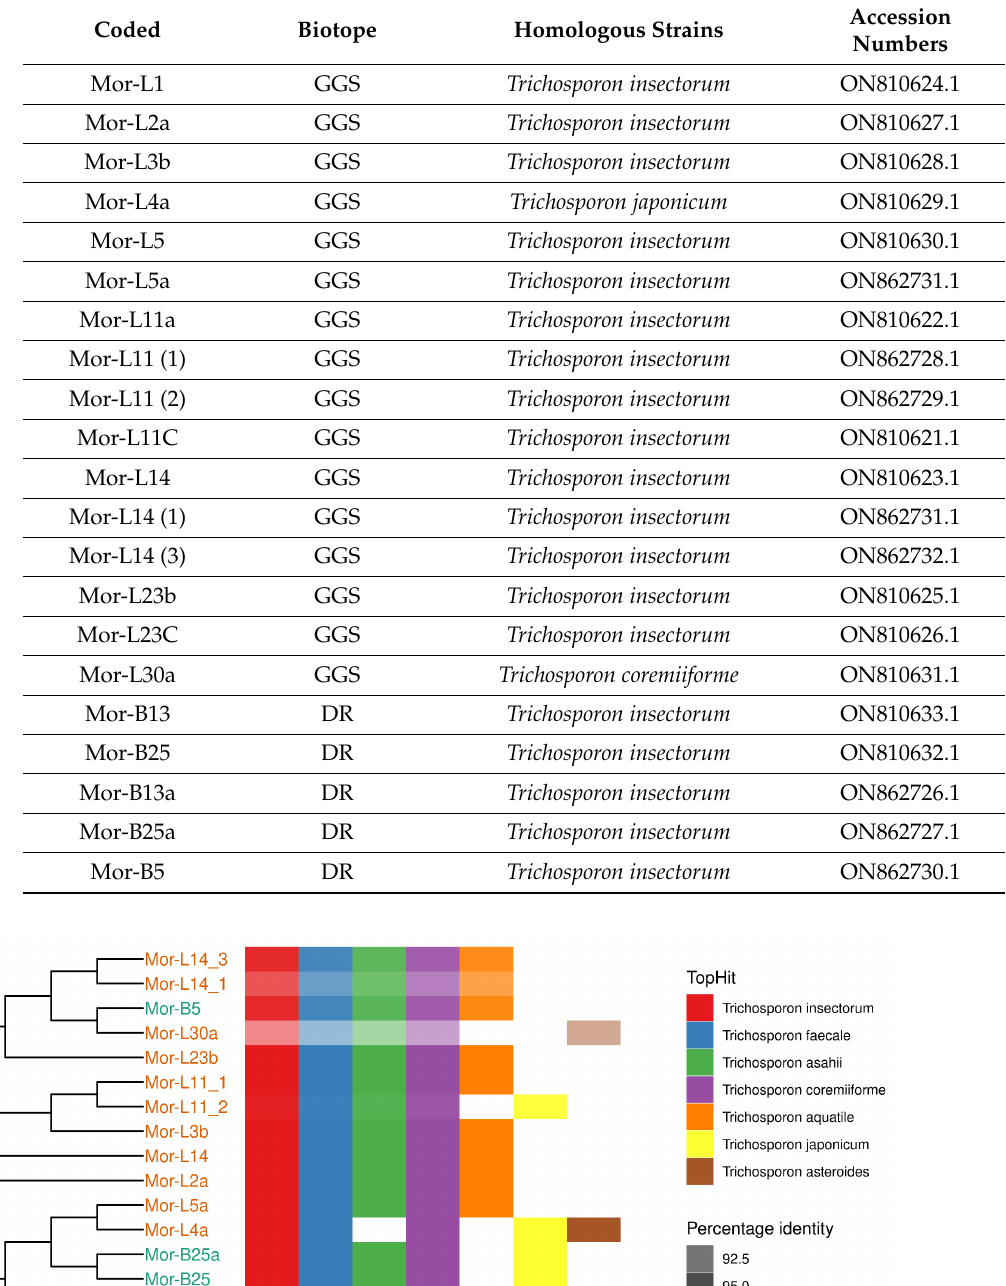
Table 6. Results of yeast identification by rDNA internal transcribed spacer (ITS).